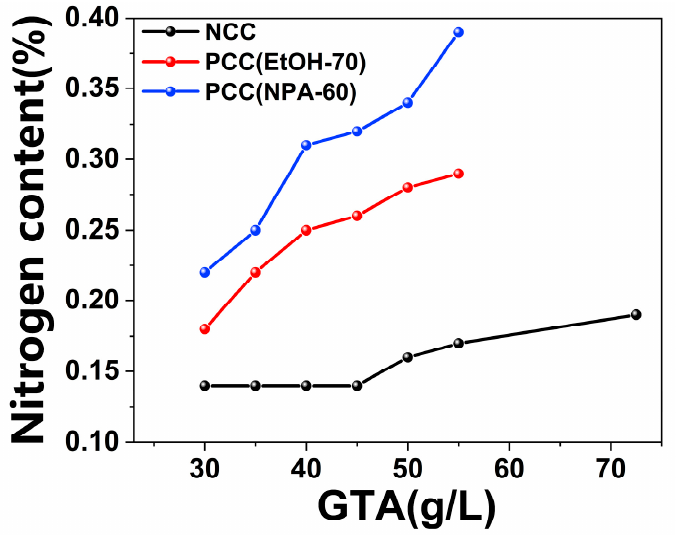
Figure 4. Nitrogen content of natural-cationic fiber (NCC), PCC(EtOH-70), and PCC(NPA-60) with different GTA dosage, the latter two were the cationic samples of PC(EtOH-70) and PC(NPA-60) which were pretreated with ethanol-water-NaOH (70 g/L) and n -propanol-water-NaOH (60 g/L).